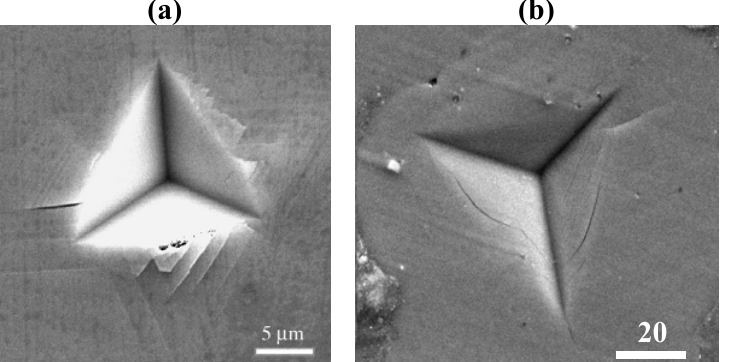
Figure 2 . SEM images of indentations placed on ( a ) Al loads such as ( a ) F = 1.0 N and ( b ) F = 1.5 N by using trihedral indenter with the angle at the tip